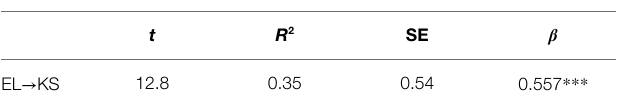
TABLE 5 | Direct path.